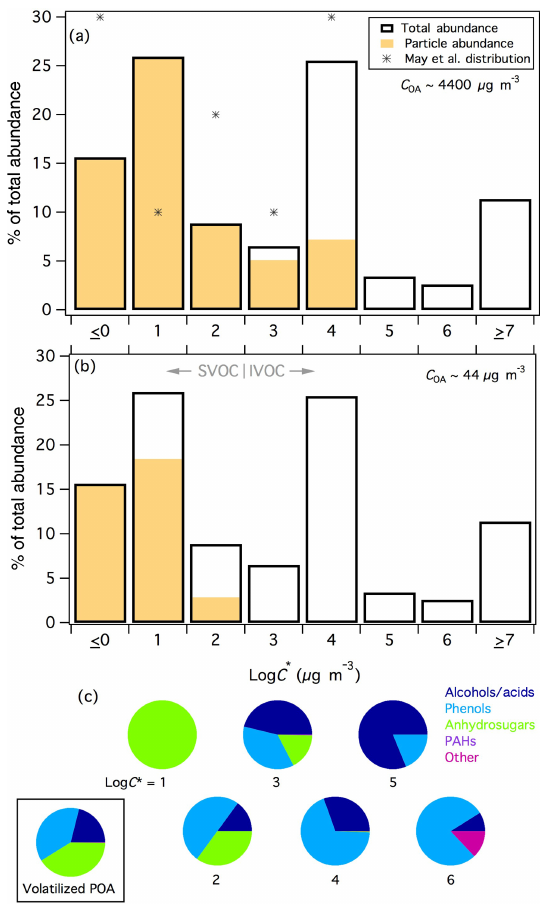
Figure 6. (a) Volatility distribution of compounds observed in fresh rotten log smoke. Markers represent the derived volatility distribu- tion for biomass-burning smoke organic aerosol from May et al. (2013). Particle- (gas-) phase only compounds are lumped into the log C ∗ ≤ 0 ( ≥ 7) bin. (b) As in panel (a) , for a theoretical 100-fold evaporation of POA. (c) Speciation of the compound classes con- tributing to each volatility bin with measurable C ∗ values. The pie chart bounded by the box shows the speciation of the I/SVOCs that were predicted to volatilize from the particle phase across all volatil- ity classes following evaporation of POA represented in panel (b)